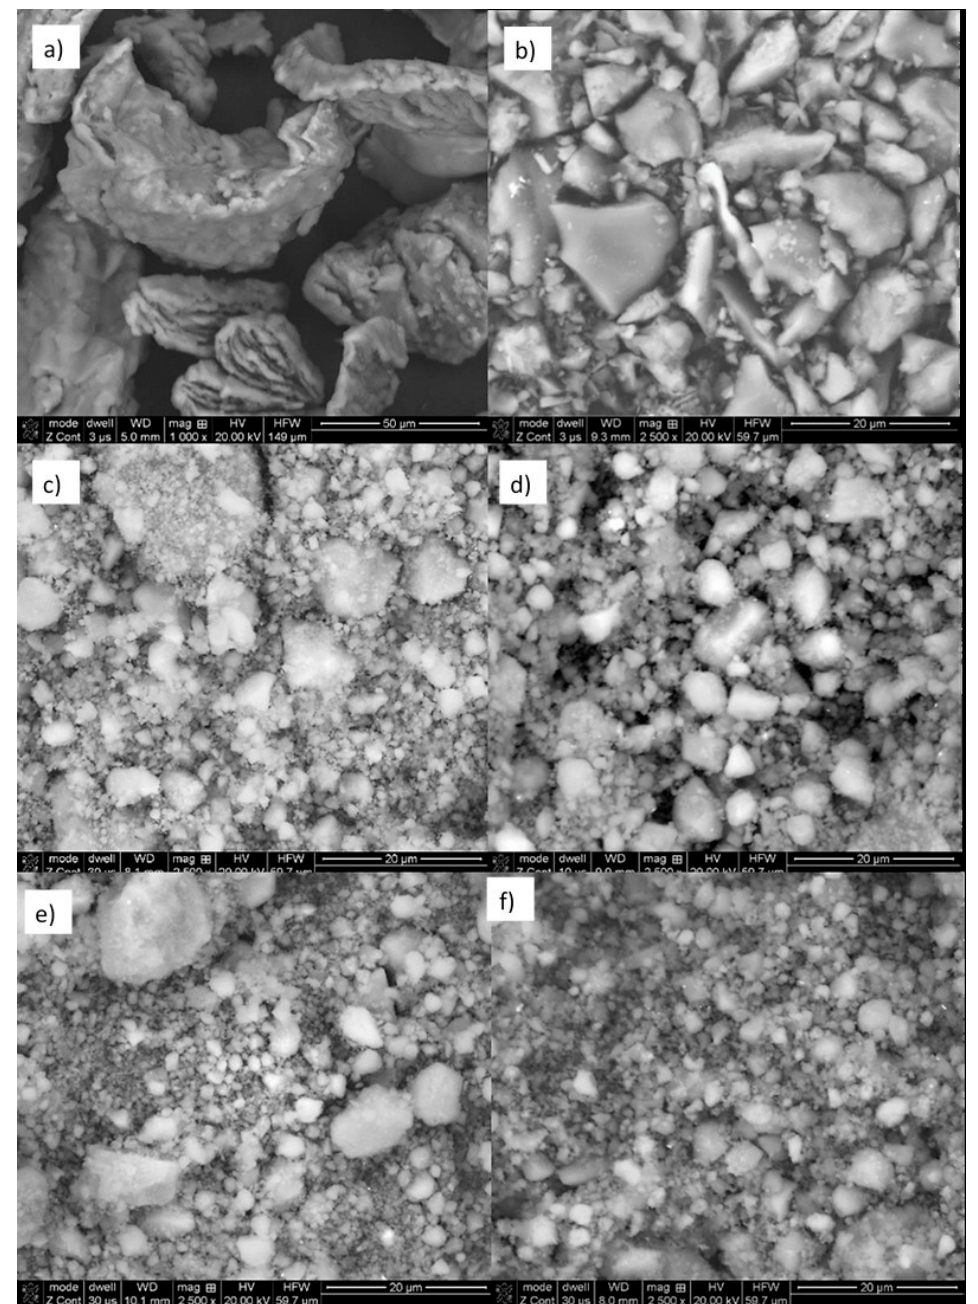
Figure 1. The morphology of the MgH 2 powders: as-received ( a ) and after milling for 10 s ( b ), 15 min ( c ), 45 min ( d ), 135 min ( e ) and 300 min ( f ). Table 1. Morphological properties of the MgH 2 powder before and after milling for various times.